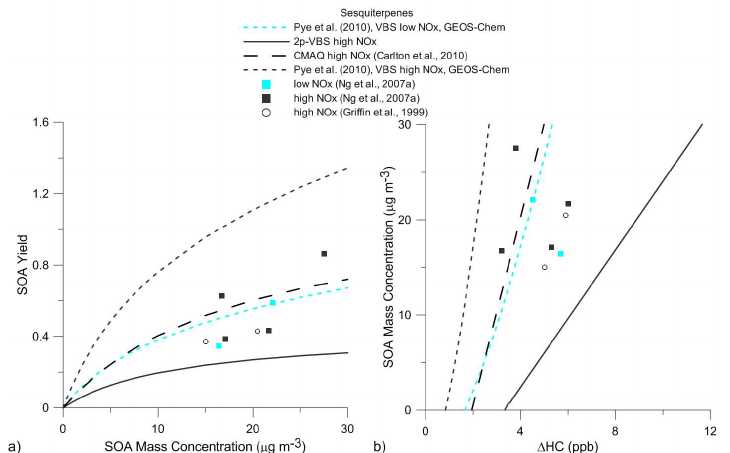
Fig. 4. Evaluation of 2p and 2p-VBS parameterizations for lumped sesquiterpenes under low-NO x (cyan) and high-NO x (black) conditions. (a) Theoretical yield curve (SOA yield vs. SOA mass concentration); (b) predicted SOA mass curve (SOA mass concentration vs. level of reacted hydrocarbon, 1